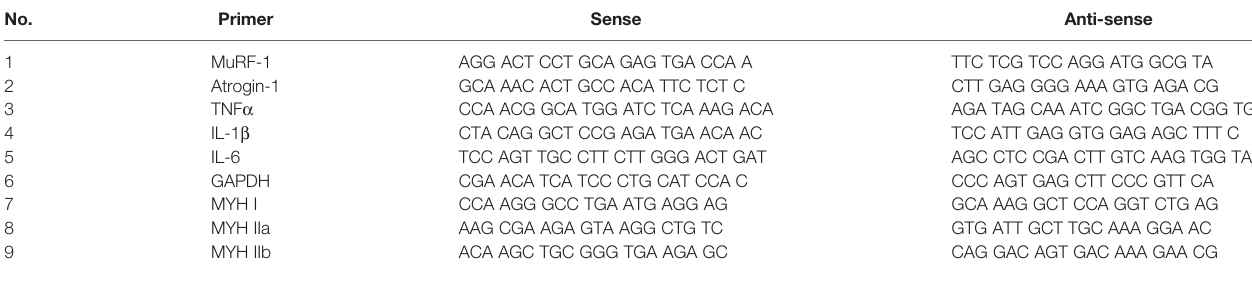
TABLE 1 | Primer sets used for quantitative PCR